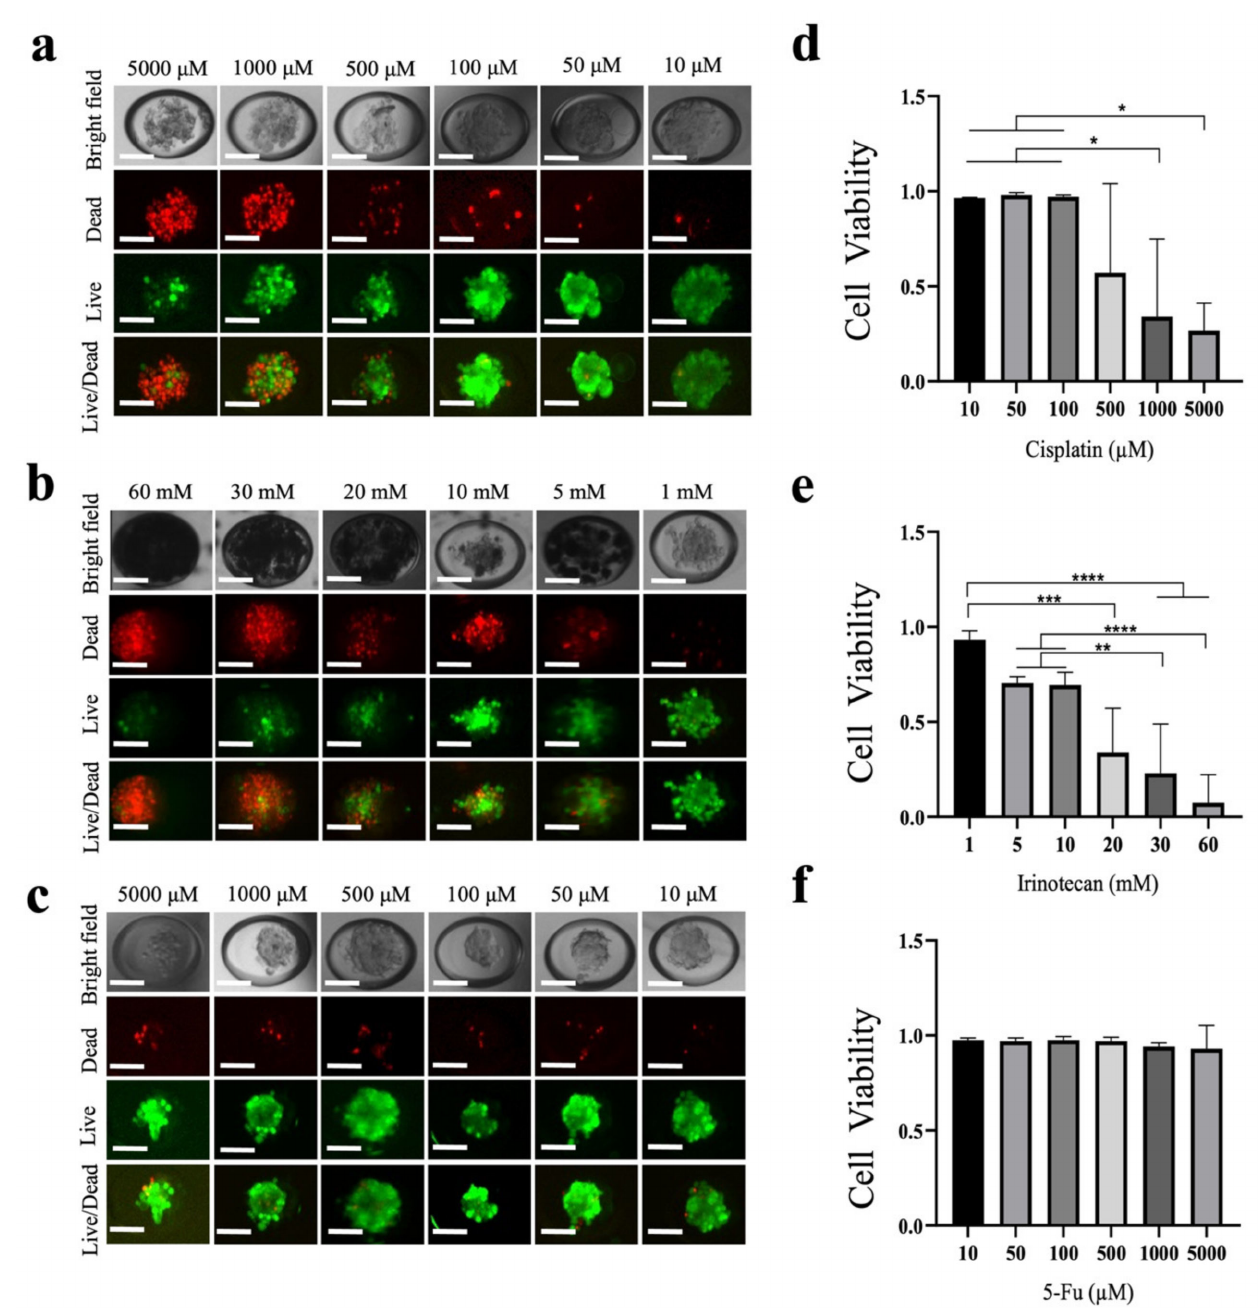
Figure 3. Drug toxicity studies in a 3D cell microdevice. Representative brightfield and live/dead fluorescence images of MCF-7 spheroids treated with different concentrations of ( a ) cisplatin, ( b ) irinotecan and ( c ) 5-FU. Scale bar = 100 µ m. The viability of MCF-7 spheroids after treatment with different concentrations of ( d ) cisplatin, ( e ) irinotecan and ( f ) 5-FU. * p < 0.05, ** p < 0.01, *** p < 0.001, **** p < 0.0001 comparison between the two drug